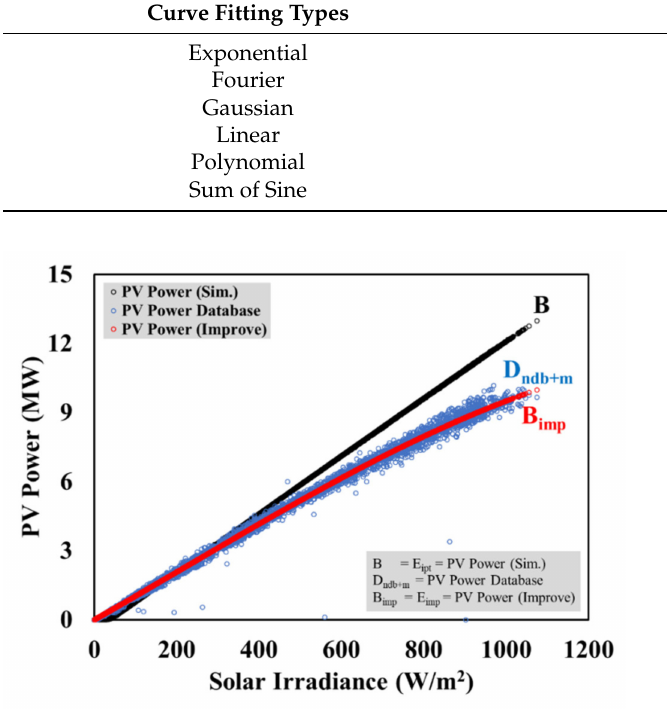
Figure 12. Simulation result of the accuracy improvement.